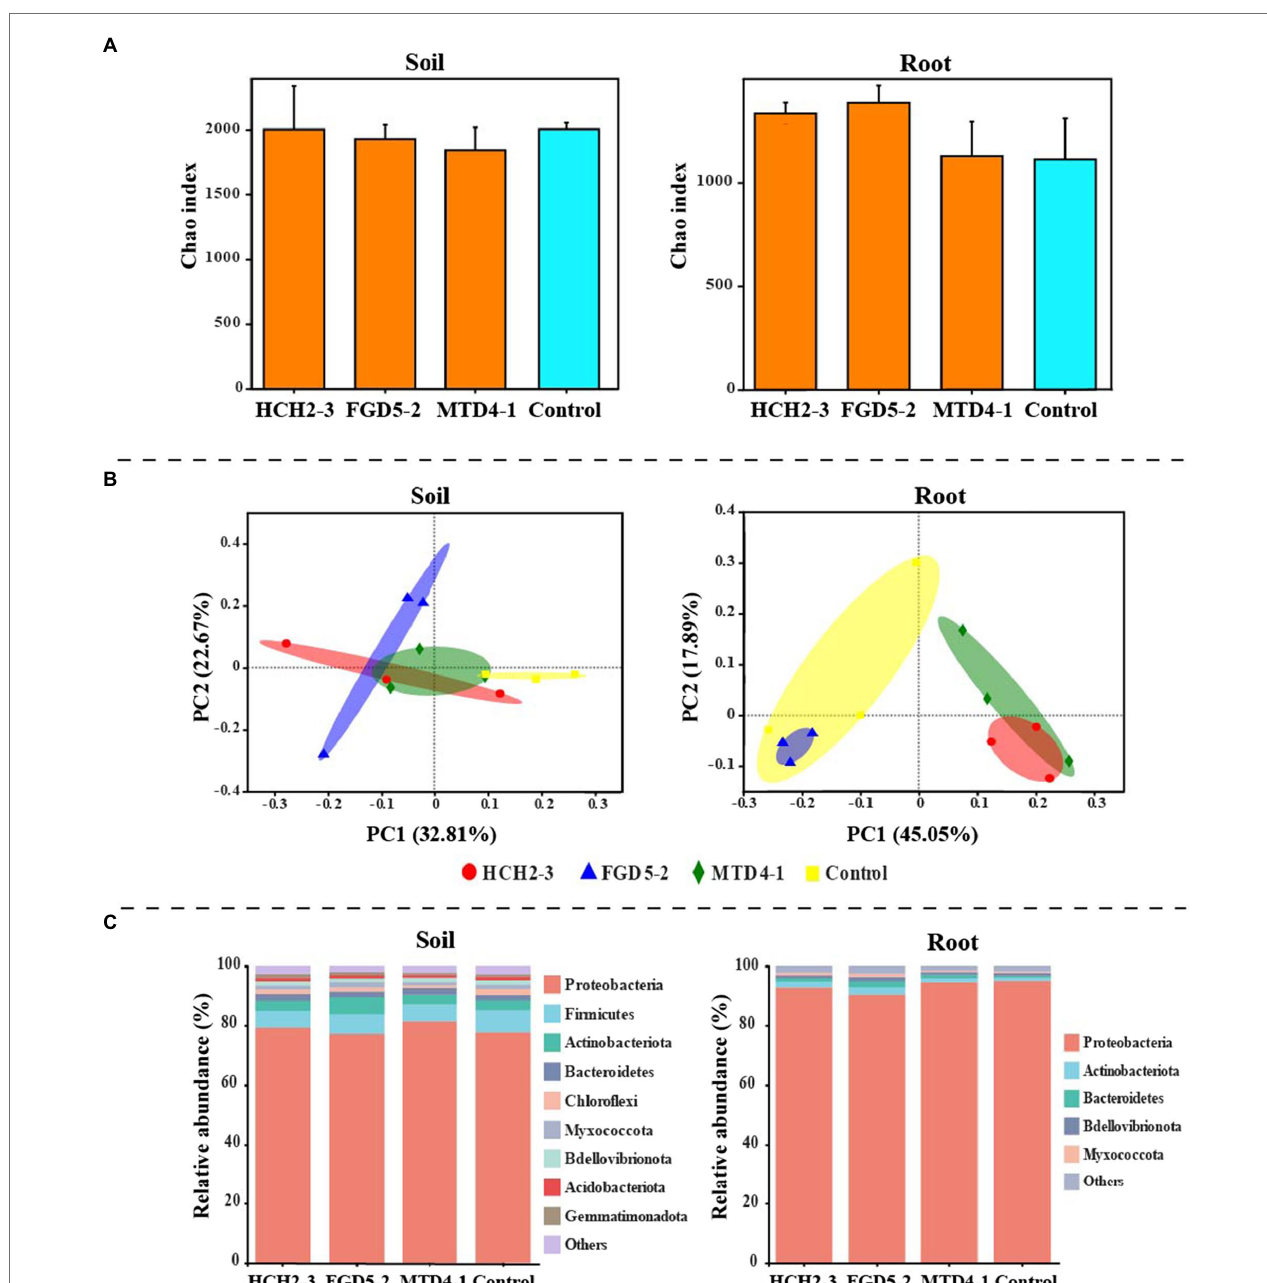
FIGURE 2 | Bacterial community composition in different samples. Alpha diversity indices of bacteria in rhizosphere soil and root (A) . Principal coordinate analysis (PCoA) of the bacterial communities in different samples (B) . Bacterial community composition in soil and root samples (C) at the phylum level. PCoA was based on Bray-Curtis distance at the operational taxonomic unit (OTU) level. HCH2-3, P. koreensis ; FGD5-2, P. lurida ; and MTD4-1, P. rhodesiae